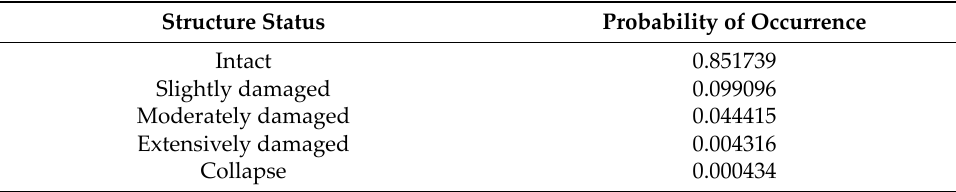
Table 6. Probability of occurrence of different levels of damage to the